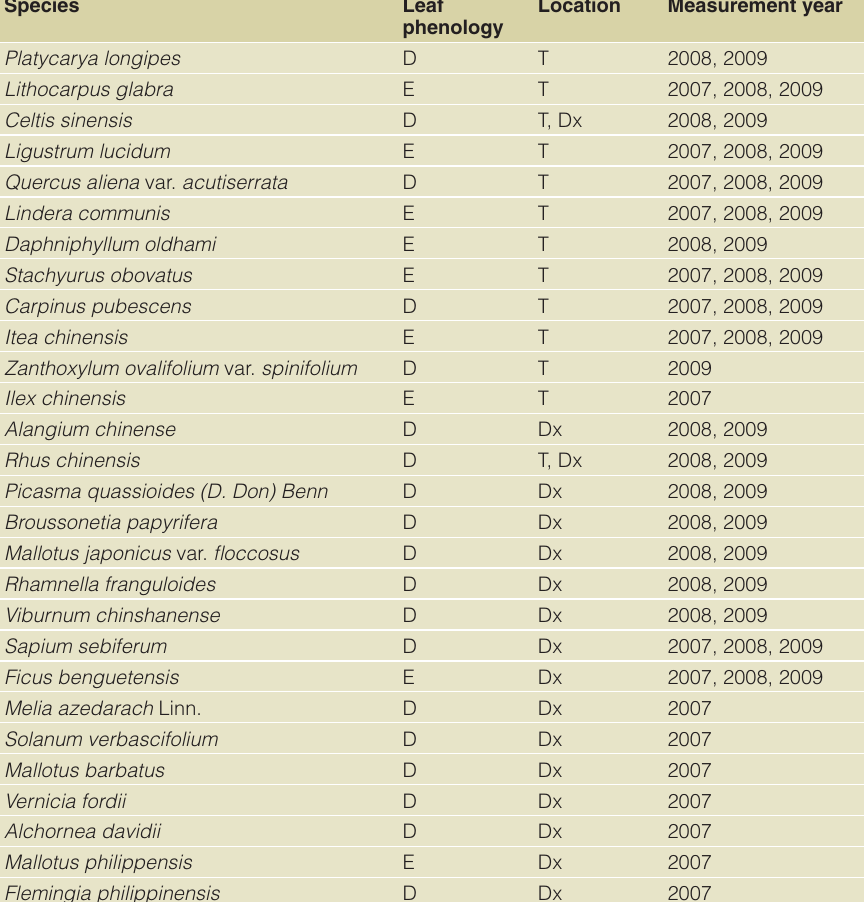
Table 1. Characteristics of the tree species examined in this study. For leaf phenology, D represents deciduous and E represents evergreen; For location, T represents Tianlongshan and Dx represents